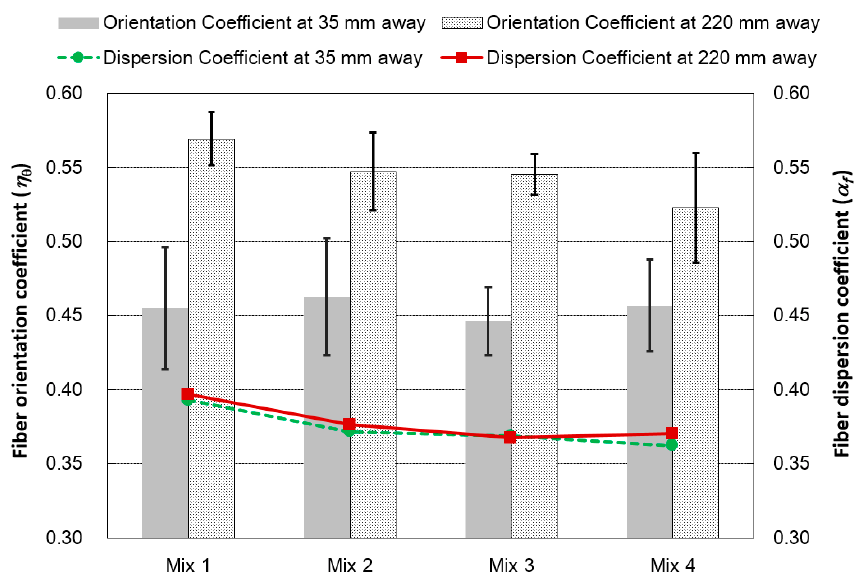
Figure 11. Fiber orientation coefficients and fiber dispersion coefficients of UHPFRC. Table 3. Correlation of properties of UHPFRCs.